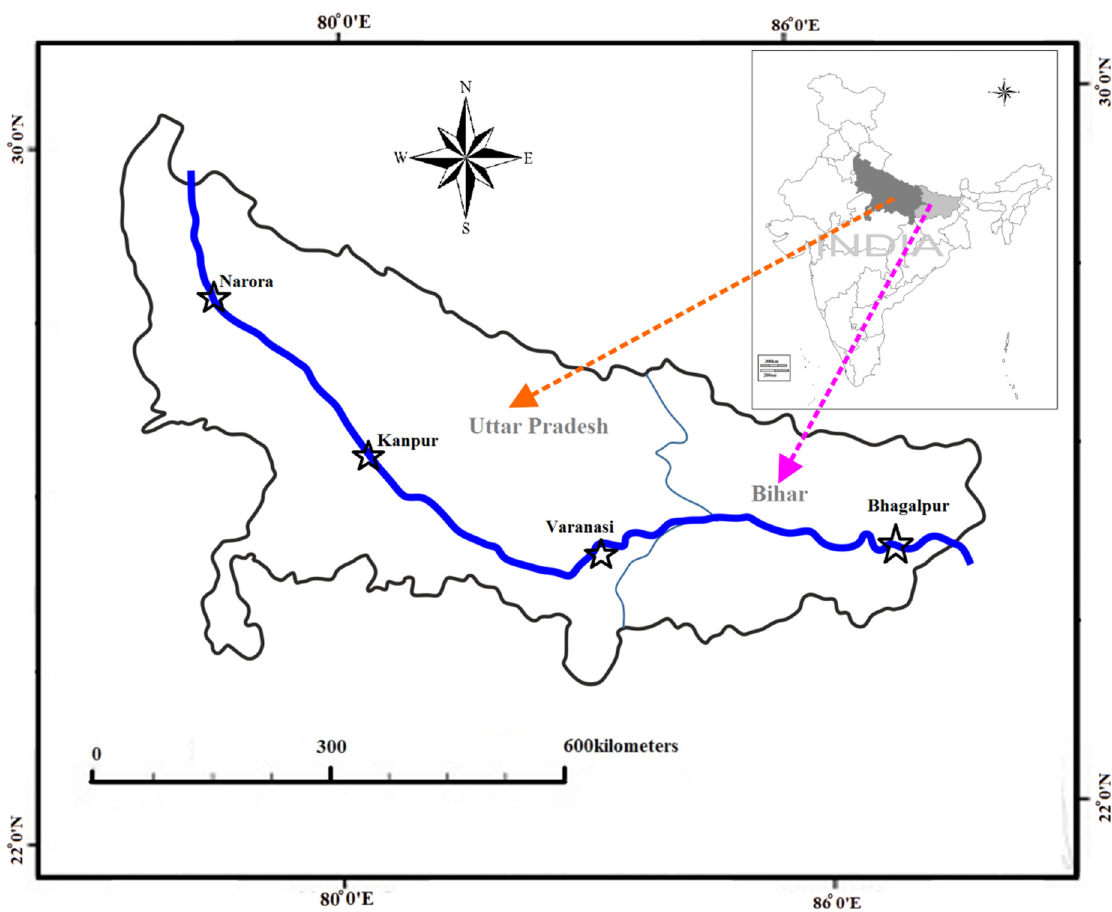
Fig. 1. Map showing the sampling sites of Sperata aor across the river